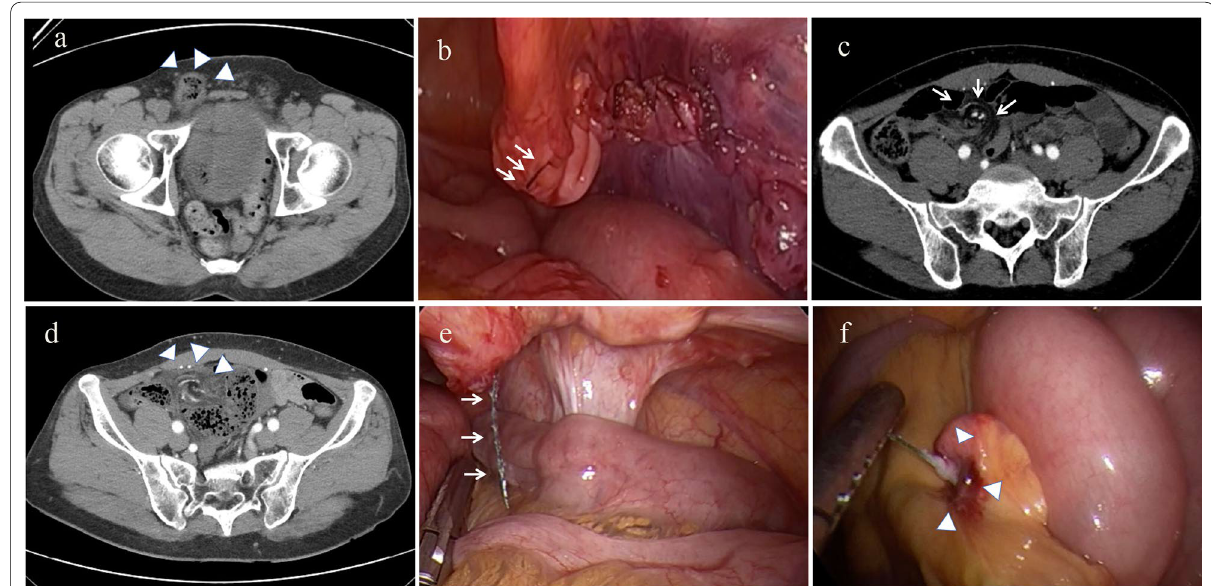
Fig. 1 Preoperative and intraoperative images in Case 1. a CT shows right indirect inguinal hernia in prone position (white arrowheads). b A